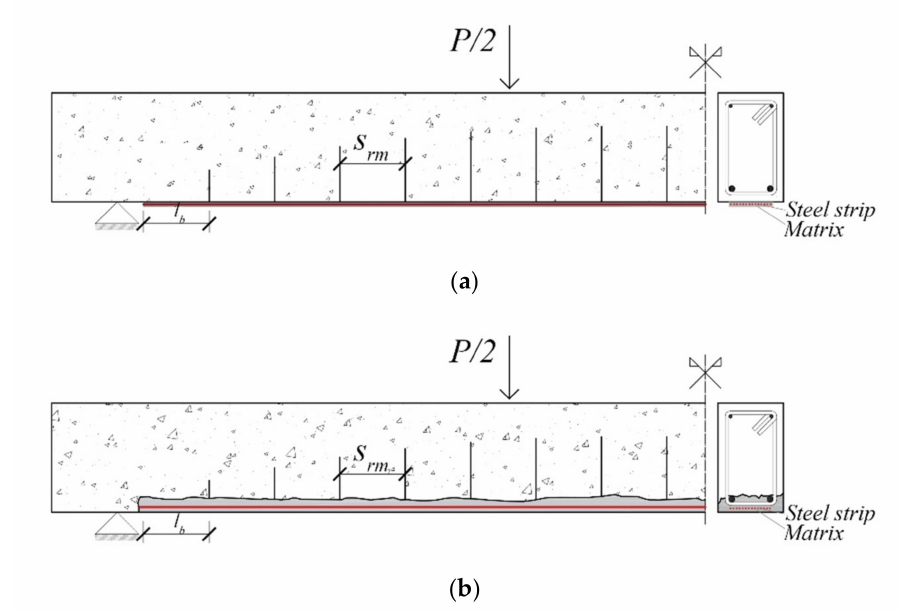
Figure 3. Strengthened RC beams: ( a ) EB technique; ( b ) IRS